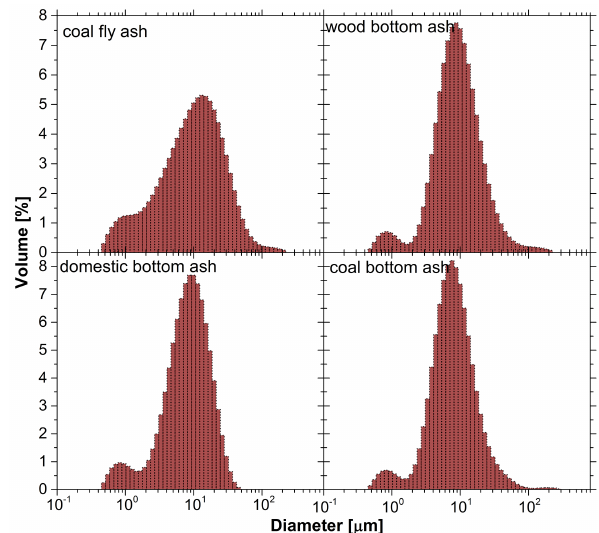
Figure 3. Particle size distribution of suspended combustion ash particles – coal fly ash (CFA), wood, domestic, and coal bottom ashes. The size distribution were measured after the ash suspensions were pulsated in an ultra-sonic bath for about 10min and stirred for ∼ 24h before the laser diffraction measurement. Each plot of the size distribution shown for each ash sample is an average of three repeated measurements ( σ <